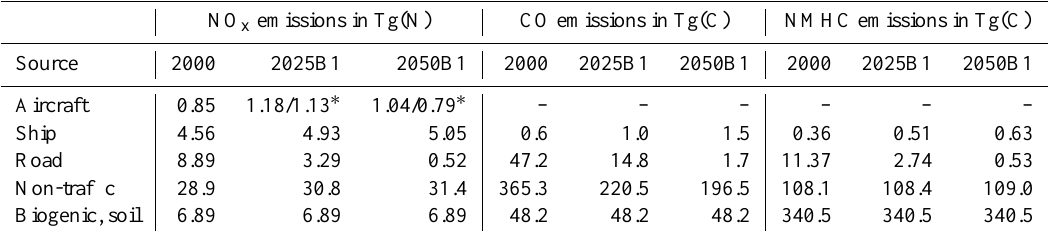
Table 1. Global annual emissions of NO x , CO and NMHC provided by QUANTIFY (http://www.ip-quantify.eu) for the years 2000, 2025 and 2050 in the B1 scenario. The 2000 emissions are from the final QUANTIFY dataset and thereby differ from the preliminary emissions used in Hoor et al.